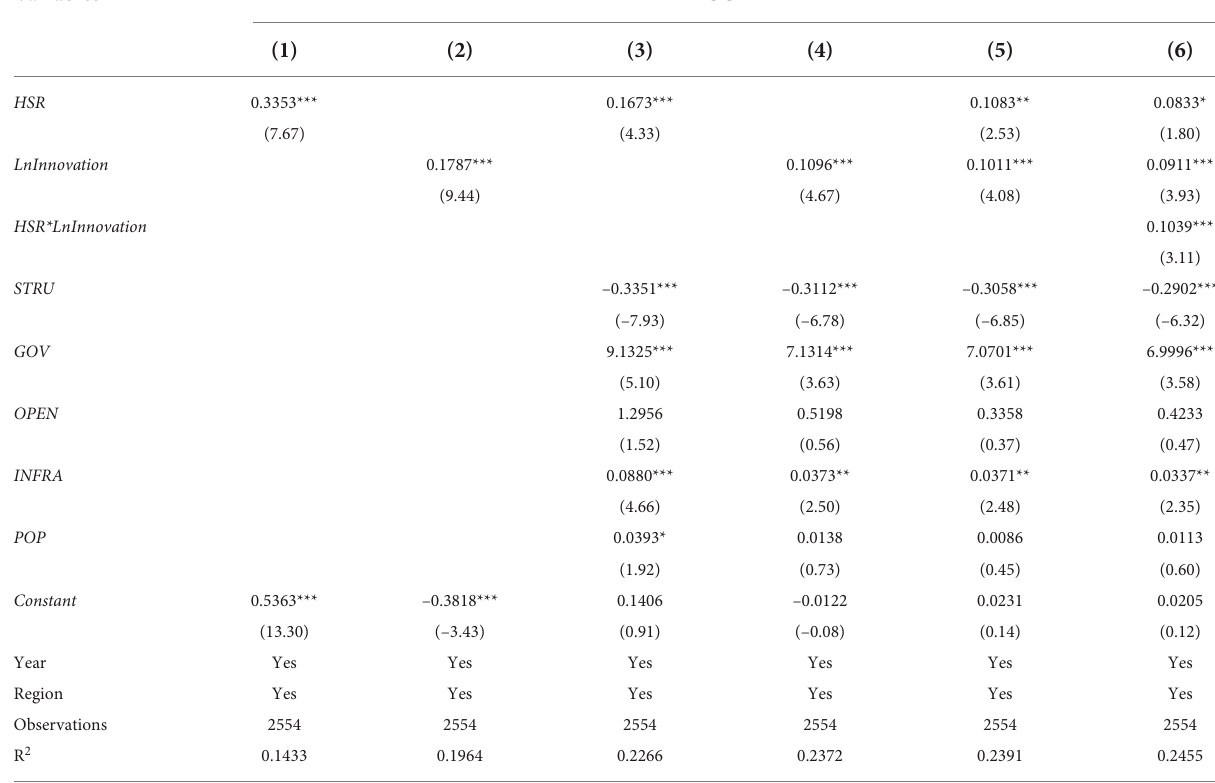
TABLE 4 The regression results of the baseline